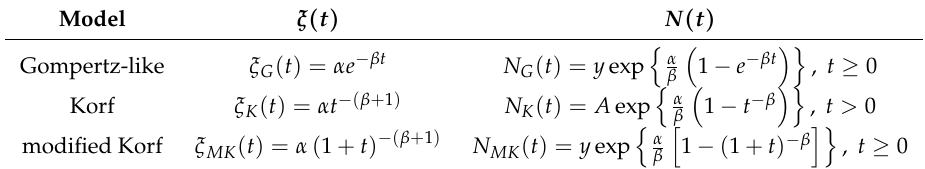
Table 1. Some choices of the time-dependent growth rate ξ ( t ) and the corresponding growth curves. Parameters α and β are positive constants. For Gompertz-like and modified Korf models, the quantity y > 0 represents the initial size of the population ( N G ( 0 ) = N MK ( 0 ) = y ), whereas for Korf model A is a positive constant and the initial size is